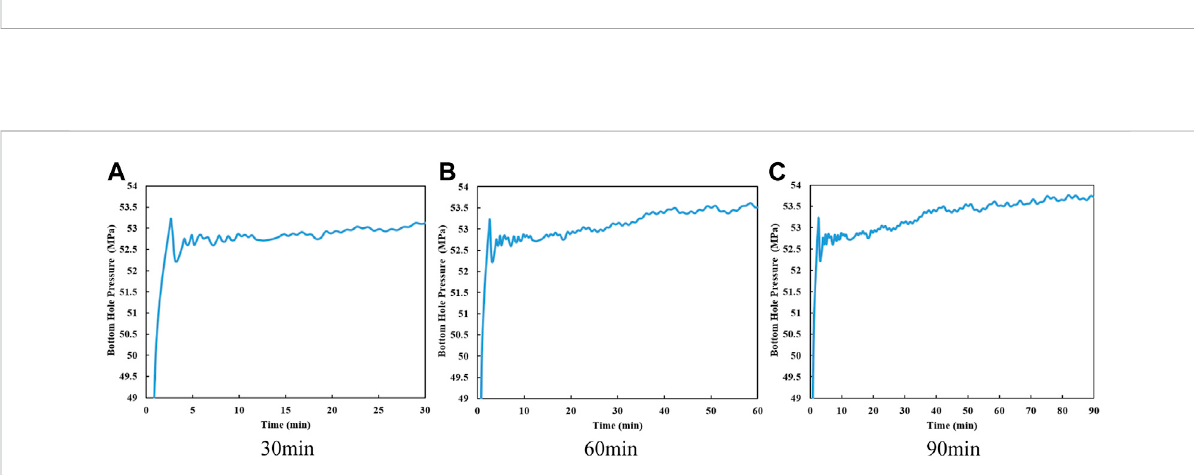
FIGURE 6 Distribution of water saturation in micro-fracture during fracture propagation. (In (A – C) , the range of water saturation is from 0.3 to 1.0. (D) is pro fi le of water saturation which is drawn from the data in the fi gure of water saturation distributon in micro-fracture during fracture propagation (such as (A – C) and so on)).